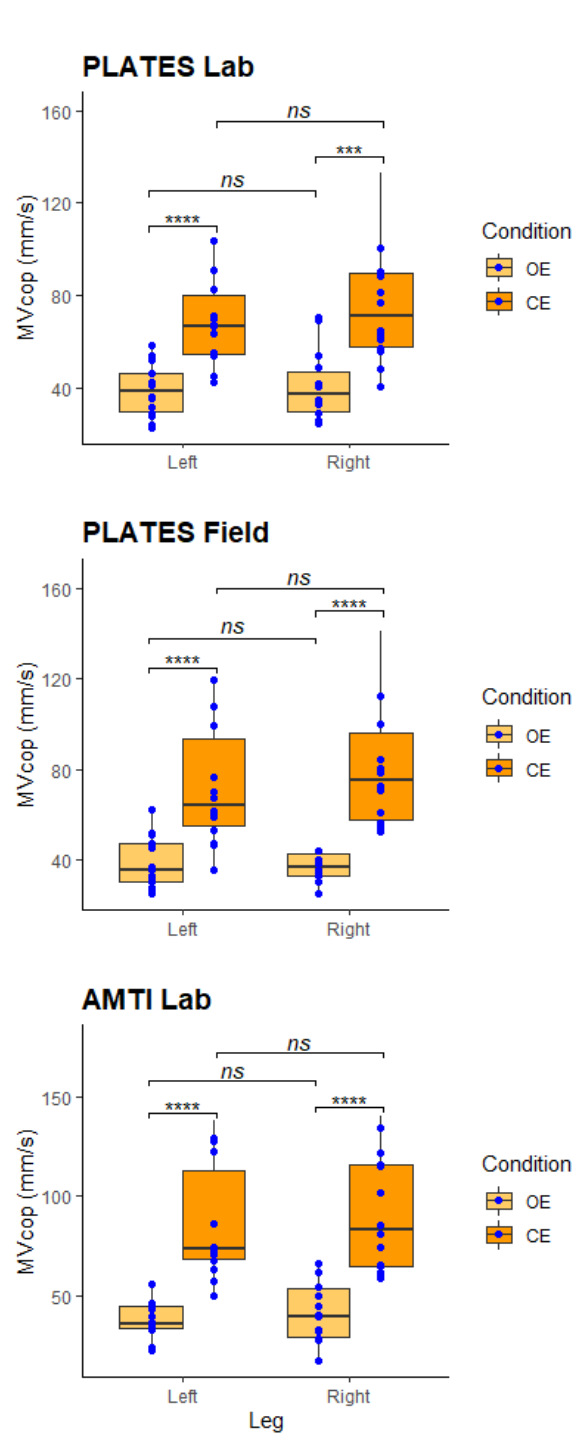
Figure 1. MVcop during the Single Leg Balance test. Upper panel: AMTI measures in the laboratory. Middle panel: PLATES measures in the laboratory. Lower panel: PLATES measures in the field. In each panel, the boxplot represents MVcop in the 4 experimental conditions: standing on the left/right leg with the eyes open/closed. Each blue circle represents the average of the 3 repetitions performed by each participant ( n = 14). Paired Wilcoxon test, ns : no significant difference, *** p < 0.001, **** p < 0.0001. The figures replicate the classical results that stability is lower with the eyes closed for both